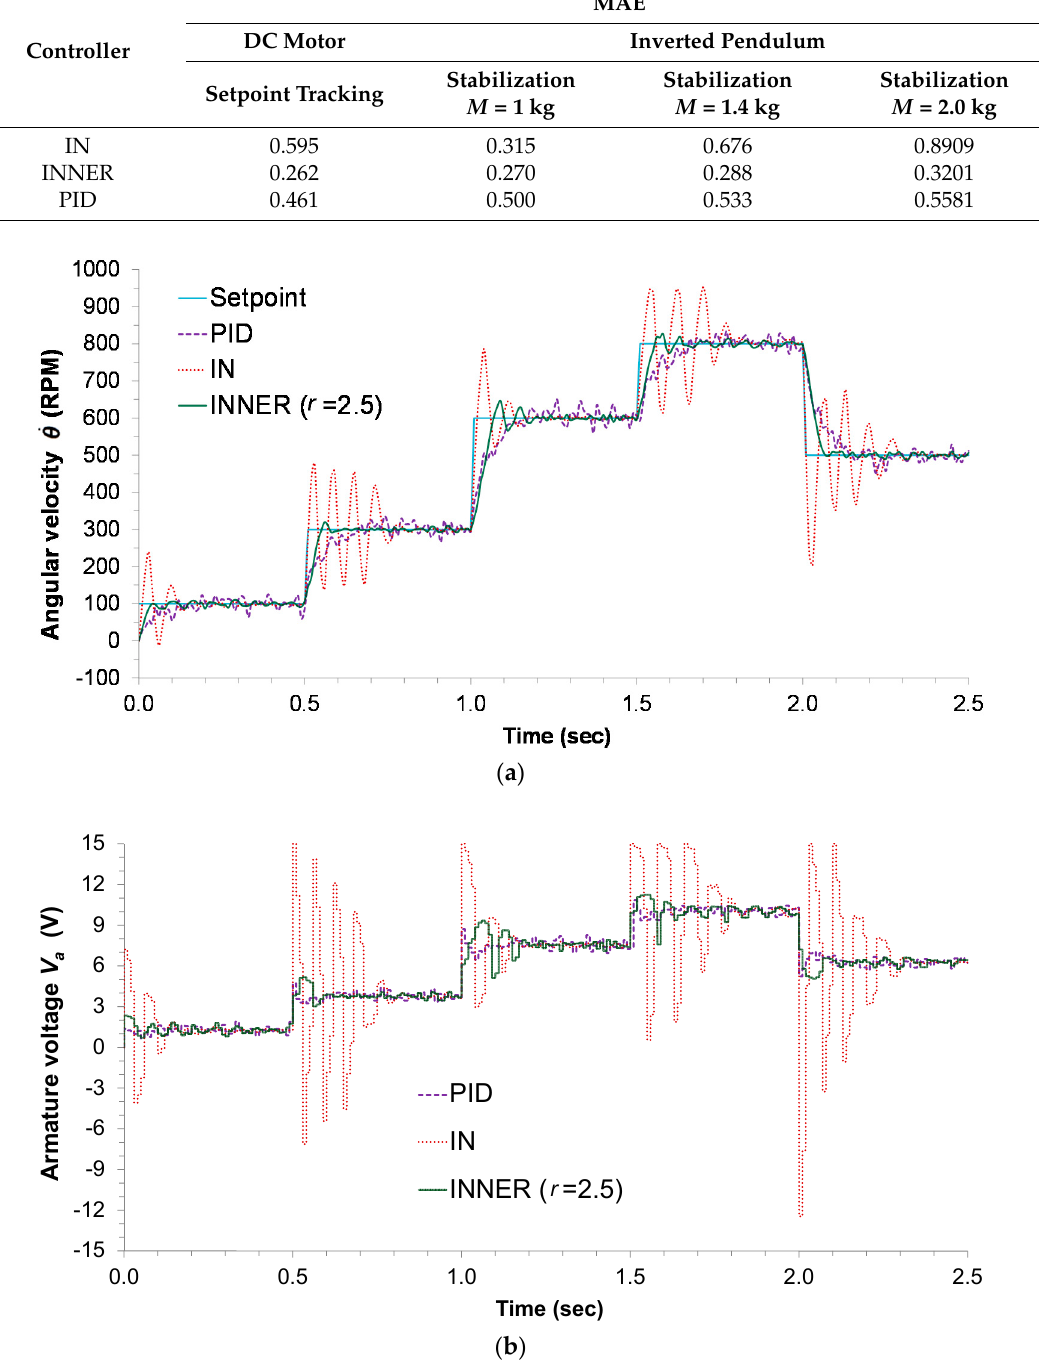
Figure 6. Armature-controlled experimental DC motor: ( a ) controller responses; ( b ) controller actions.